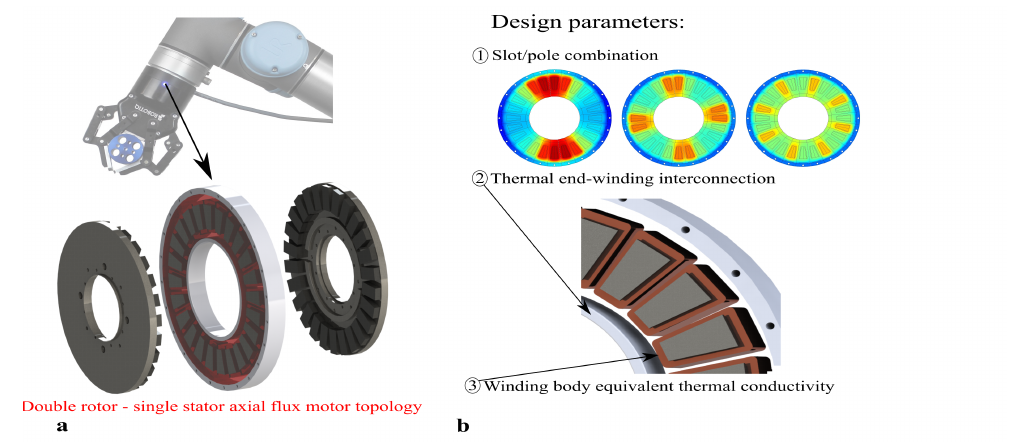
Figure 1. ( a ) The motor in a force controlled gripper has to generate high torque at (quasi)- standstill [14]. ( b ) Overview of the studied parameters in this work that potentially have a significant impact on the stall torque performance.